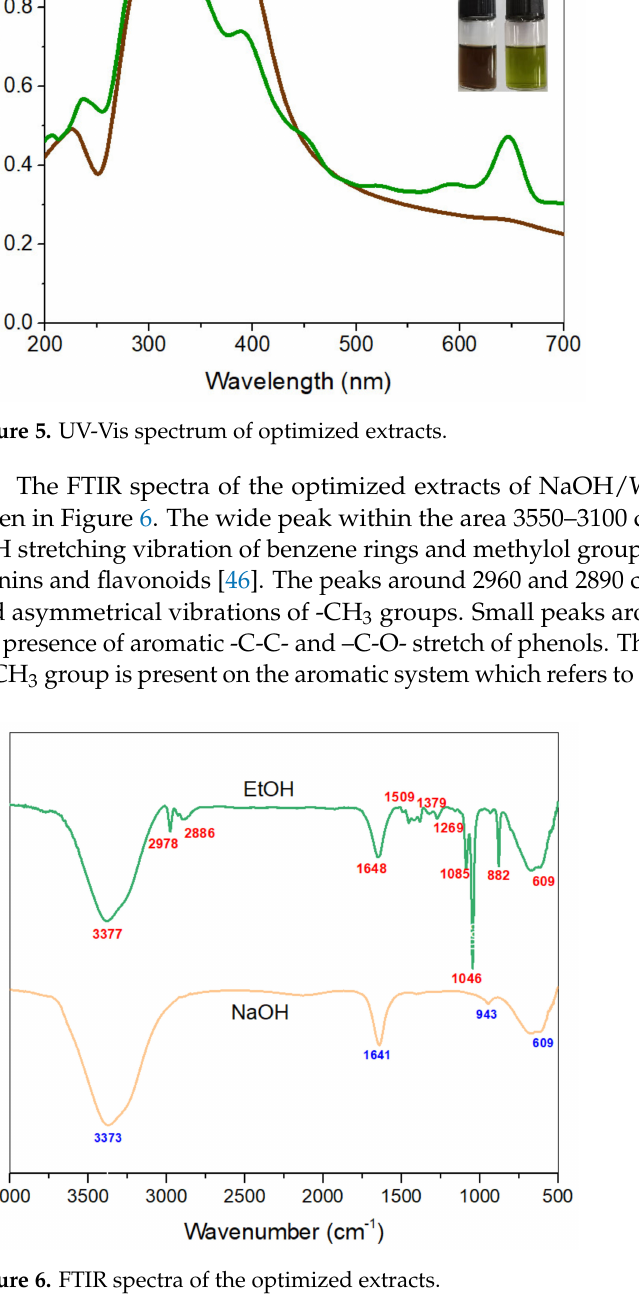
Figure 6. FTIR spectra of the optimized